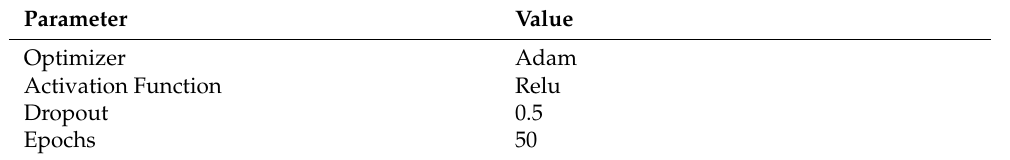
Table 8. Model Performance. Table 9. 1D-CNN Parameters.